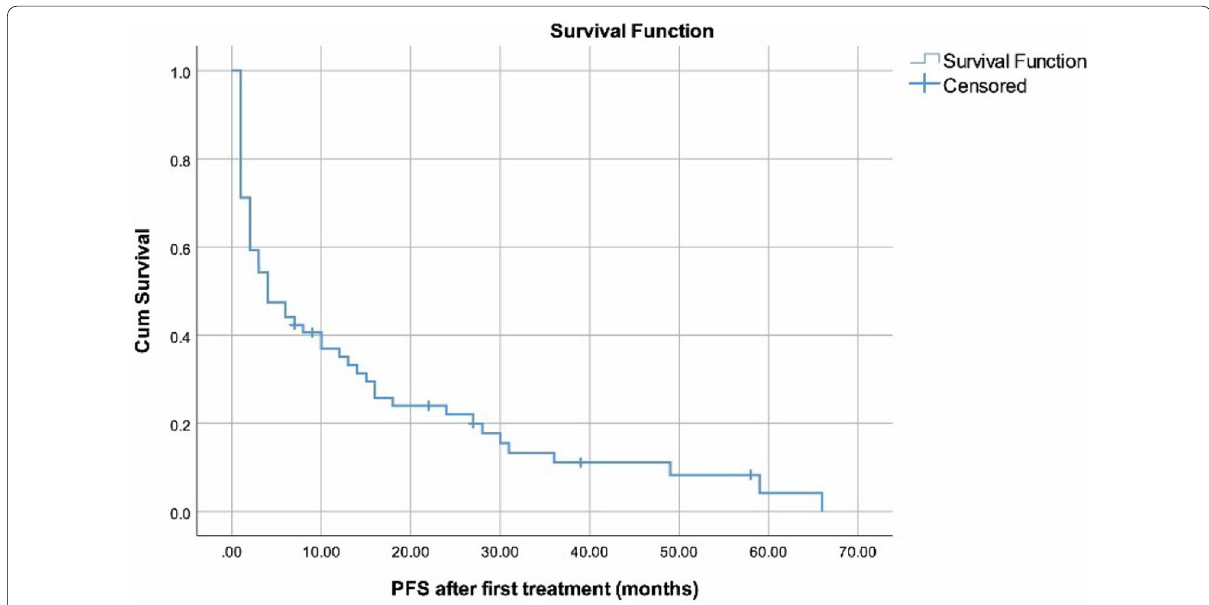
Fig. 4 Progression-free survival after first-line therapy